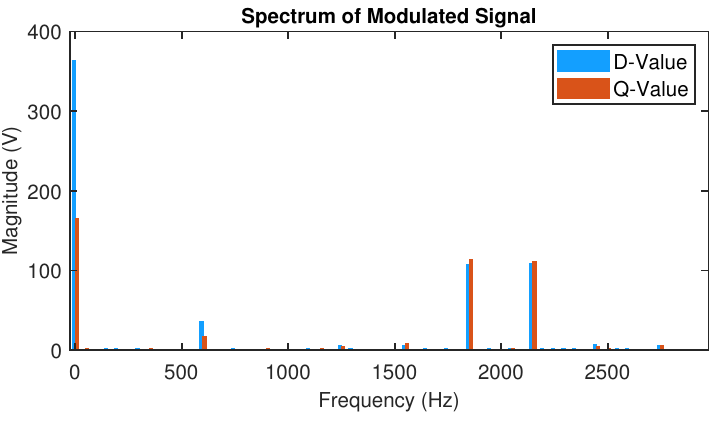
Figure 10. Spectrum of U dist,dq .